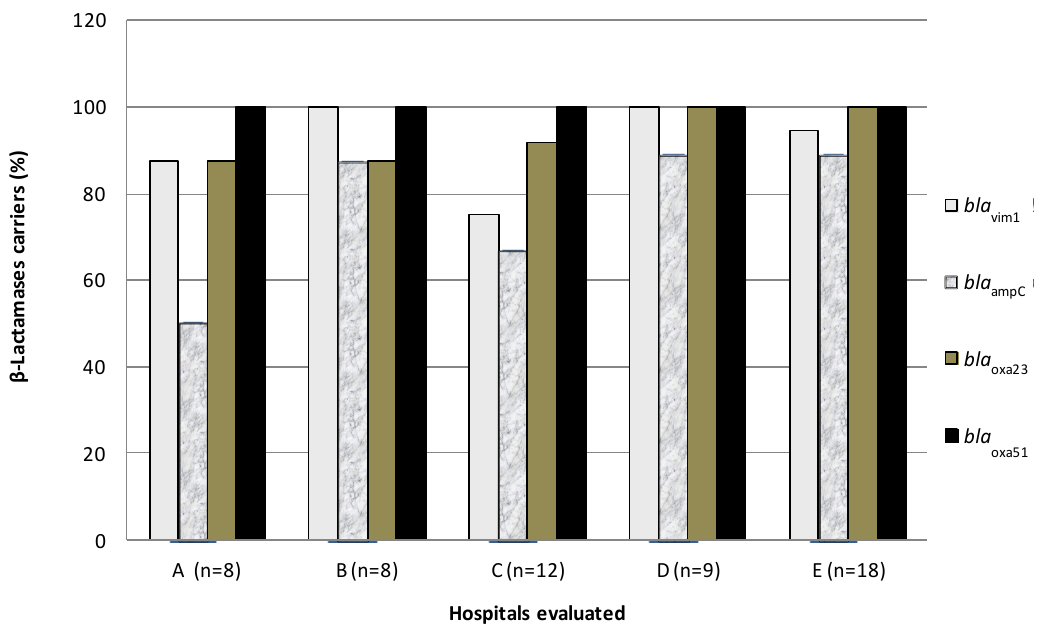
Figure 2. Percentages of bla positive A. baumannii strains, carrying genes encoding OXA51 other oxacillinases, MβLs, and cephalosporinases by